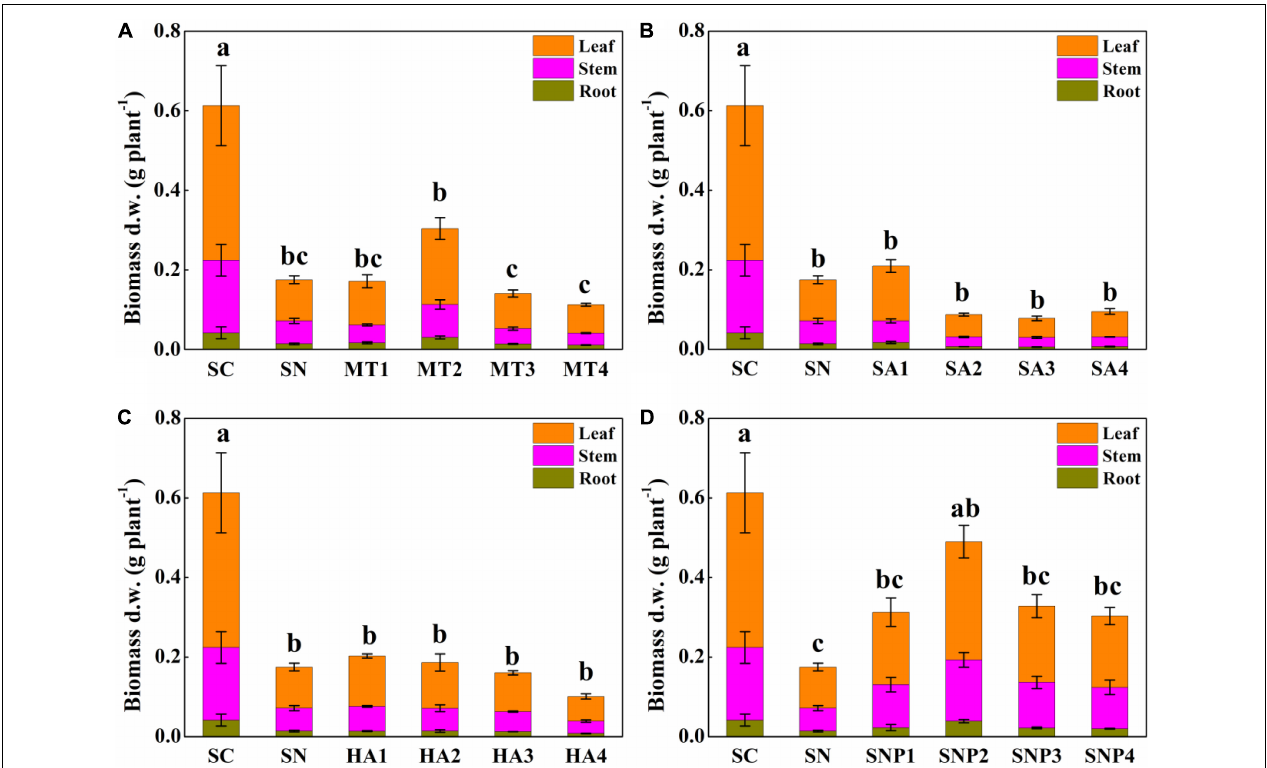
FIGURE 4 | Effects of different concentrations of (A) MT, (B) SA, (C) HA, and (D) SNP on root, stem, and leaf biomass of tomato under high-nitrate stress. SC, control; SN, high-nitrate stress treatment; MT, melatonin; SA, salicylic acid; HA, humic acid; SNP, sodium nitroprusside; MT1–4 represented SN + 25 µ mol L − 1 ,